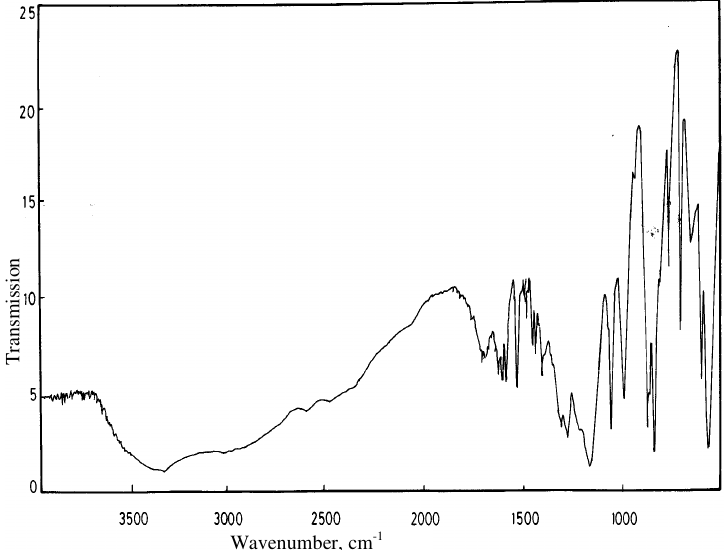
Figure 8 . FT-IR spectrum of trees / bushes pattern material for conditions shown in Figure